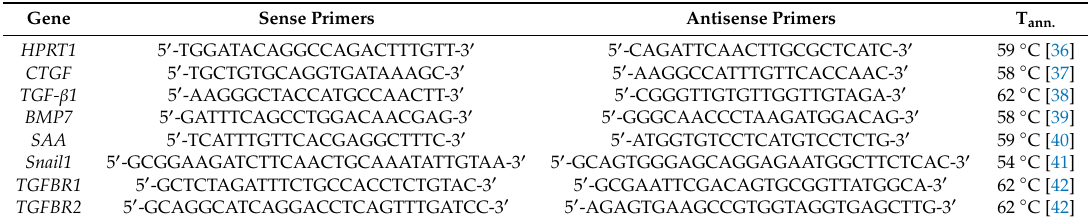
Table 1. List of primer pairs and annealing